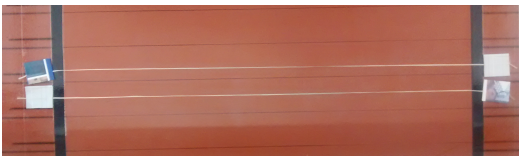
Figure 2. Typical yarns sample with sandwich type endings.